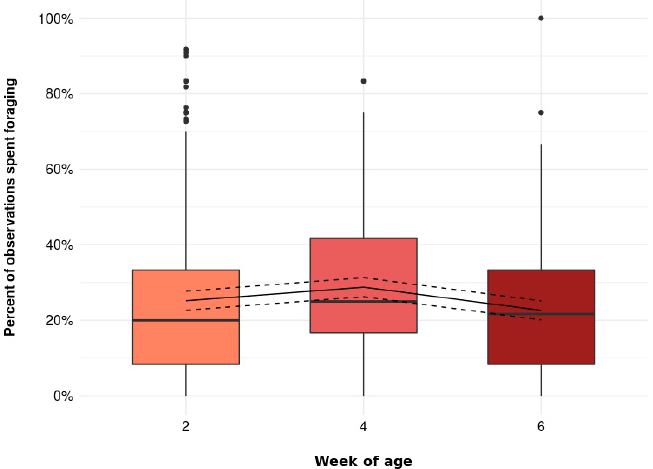
Figure 2. The percent of observations spent foraging (including foraging active and foraging inactive) at 2, 4, and 6 weeks of age ( p = 0.001). Boxplots show medians, lower, and upper interquartile range of raw data. Whiskers indicate 1.5 times the interquartile range. Solid lines represent estimated means and dashed lines represent 95% confidence intervals.